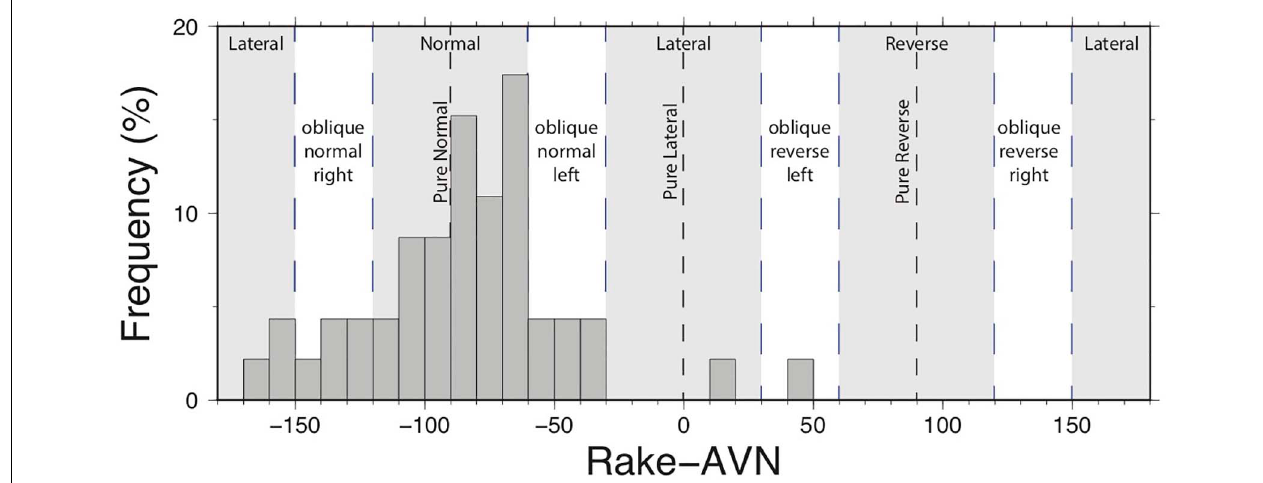
FIGURE 13 | Histogram of the rake distribution of the calculated focal mechanisms for the AVN area.